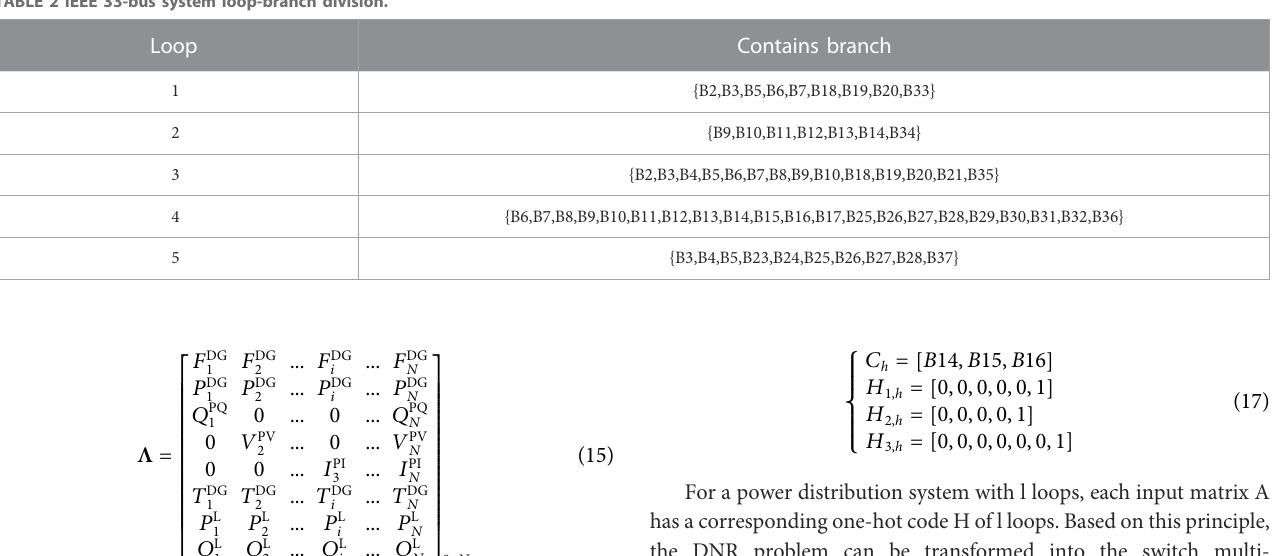
TABLE 2 IEEE 33-bus system loop-branch